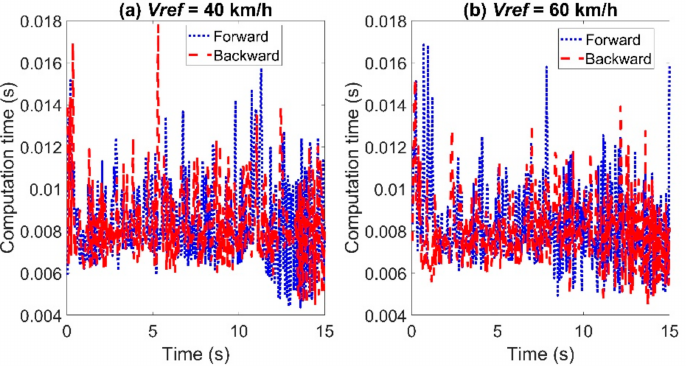
Figure 15. Comparison of the computation time for tracking the double line change path with T s = 0.05 s: left for Case ( a ) with Vref = 40 km/h and right for Case ( b ) with Vref = 60